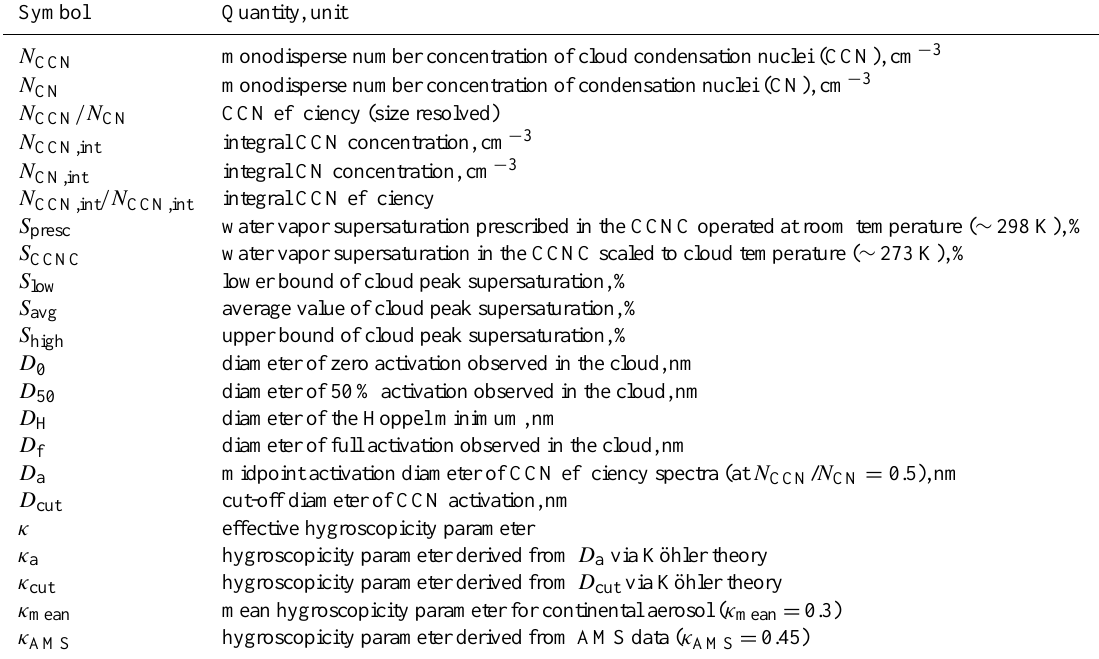
Table A1. Notation (frequently used